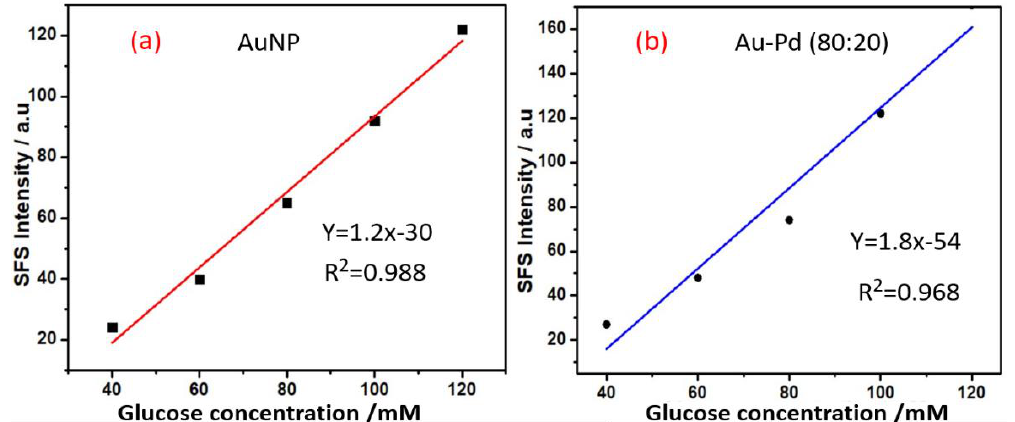
Figure 6. Linear plot ( a ) Concentration of glucose versus synchronous fluorescence spectroscopy (SFS) intensity in the presence of AuNPs with Nafion. ( b ) The concentration of glucose versus SFS intensity in the presence of bimetallic Au-Pd nanoparticles with an Au:Pd ratio of 80:20 with Nafion.